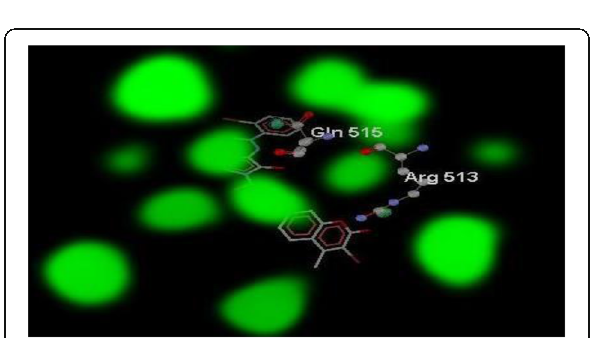
Fig. 4 Steric hindrance around compound